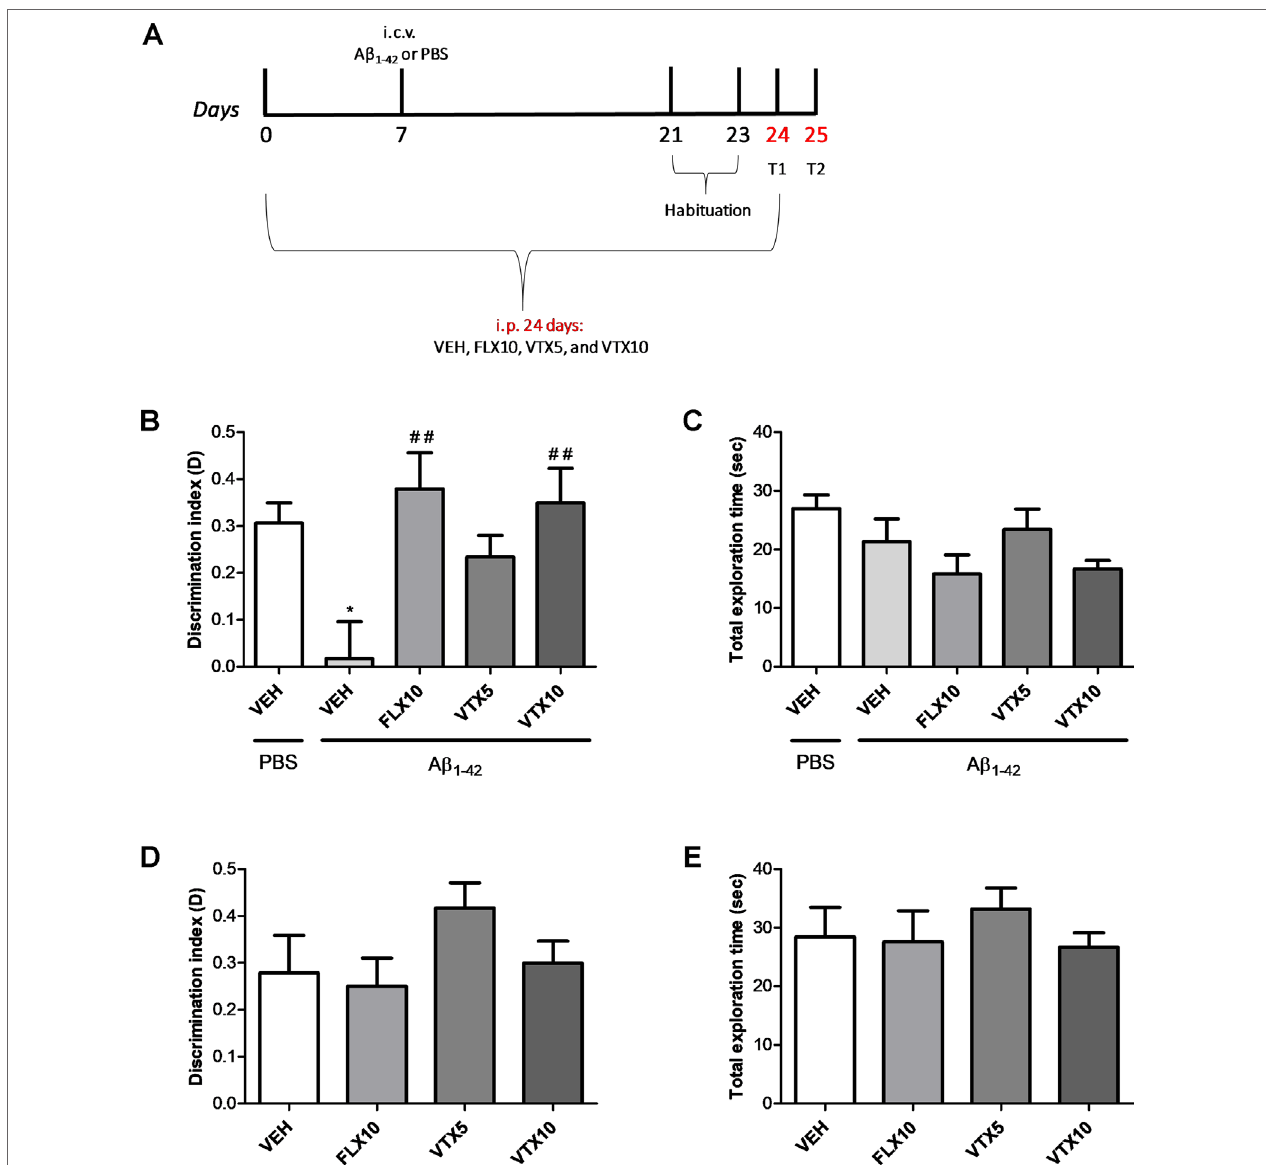
FIGURE 3 | Vortioxetine reduces the A β 1-42 -induced impairment of recognition memory. Object recognition test (ORT) was used to evaluate recognition memory by assessing the discrimination index (D). (A) Schematic representation of the experimental design. (B) The impairment of recognition memory induced by i.c.v. administration of A β 1-42 ( t (9) = 0.221, p > 0.05 for A β 1-42 group vs. zero) is completely rescued by FLX10 and VTX10 treatments (ANOVA among all: F (5,54) = 4.4; Bonferroni’s p < 0.05 between PBS + VEH and A β 1-42 + VEH; p < 0.01 between A β 1-42 + VEH and VTX10 and FLX10). (C) Total exploration time is similar among the different conditions (ANOVA among all: F (5,54) = 2.274). PBS + VEH ( n = 14), A β 1-42 + VEH ( n = 10), A β 1-42 + FLX10 ( n = 7), A β 1-42 + VTX5 ( n = 11), and A β 1-42 + VTX10 ( n = 11). (D) FLX10, VTX5, or VTX10 treatments per se do not modify discrimination index ( F (3,28) = 1.409) nor (E) total exploration time ( F (3,28) = 0.467). * p < 0.05 vs. PBS + VEH, ## p < 0.01 vs. A β 1-42 +